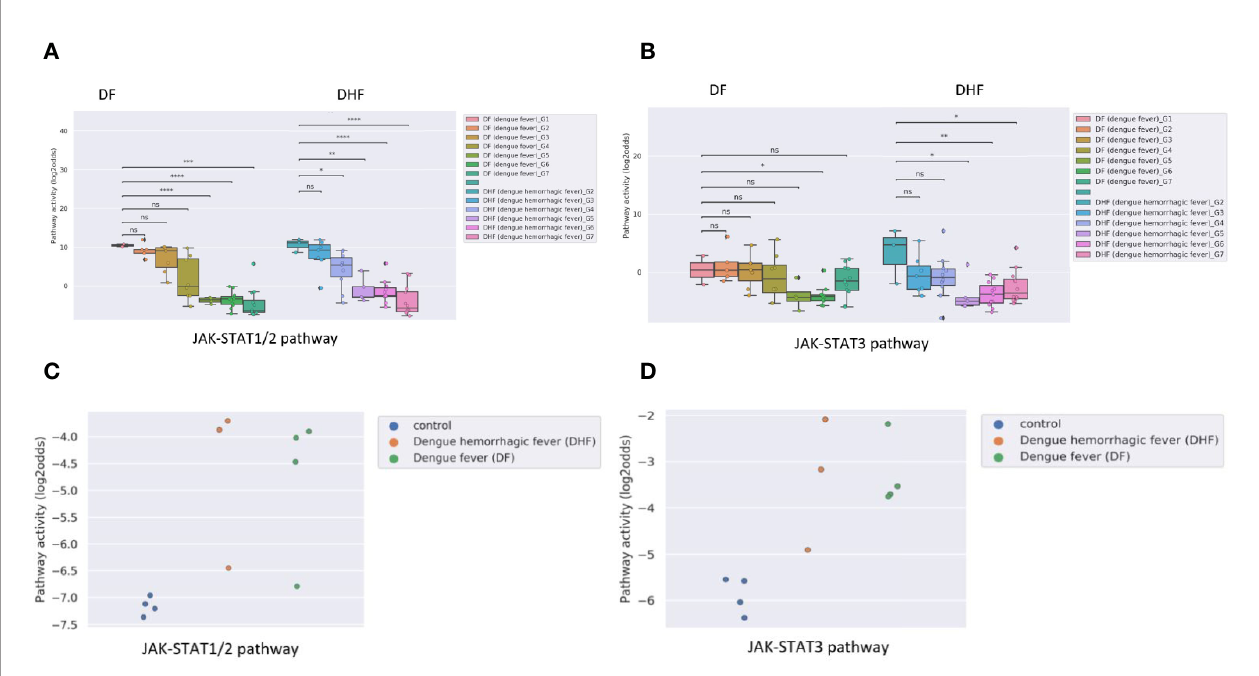
FIGURE 3 | JAK-STAT1/2 and STAT3 pathway activity analysis of dataset GSE43777 (A for STAT1-2 and B for STAT3) and dataset GSE84331 (C for STAT1-2 and D for STAT3). (A, B) . Dataset GSE43777 (36) including DF (dengue fever) and DHF (dengue hemorrhagic fever) patient samples during the course of dengue acute illness. Analysis was performed on PBMCs. Each stage represents a group of patients after x days from fever onset, Stages (days after onset fever): G1: 0 days, G2: 2 days, G3: 3 days, G4: 4 days, G5: 5 days, G6: 6-10 days, G7: >20 days. Two sided independent t-tests were performed on groups DF (dengue fever)_G1 vs all other groups (DF (dengue fever)_G2-G7), DHF (dengue hemorrhagic fever)_G2 with all other groups (DHF (dengue hemorrhagic fever)_G3-G7). (C, D) . Dataset GSE84331 (37) includes CD8+ T cells (HLA-DR+CD38+) from Dengue/DHF patients which were compared to naive (CCR7+CD45RA+) CD8+ T cells from healthy donors (Control). Pathway activity score on Y-axis in log2odds. Two sided independent t-tests were performed; p-values are indicated in the fi guresas *p < 0.05, **p < 0.01, ***p < 0.001, ****p < 0.0001 or ns (not signi fi cant).